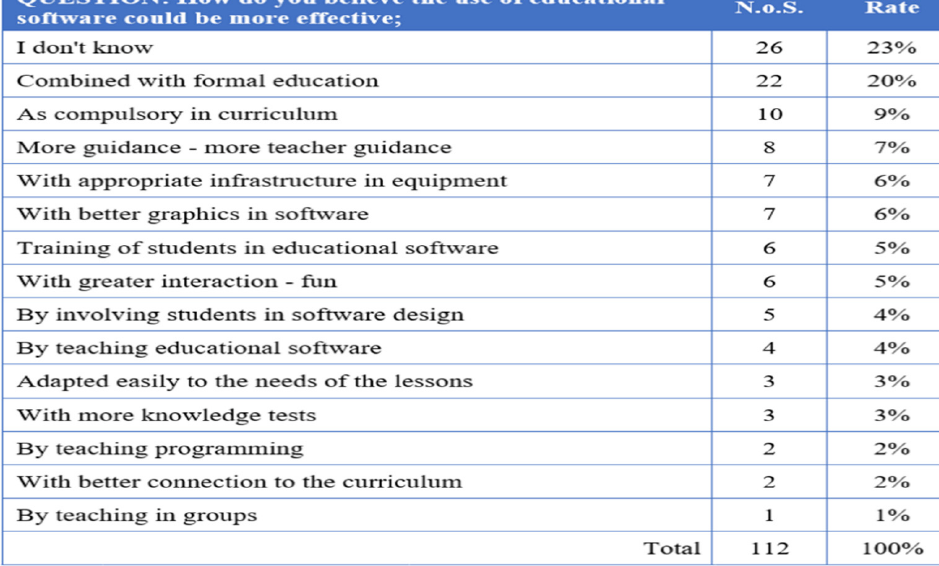
Figure 7. Answers for more efficient use of educational software.